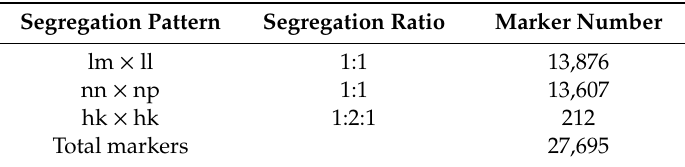
Table 2. Number of markers in each of the segregation patterns.